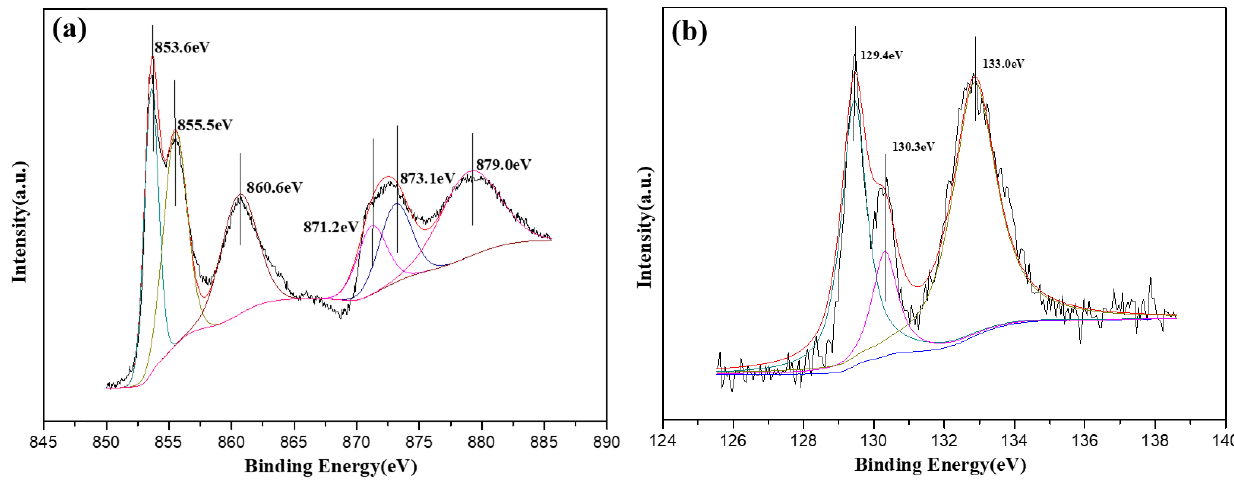
Figure 6. Peak-splitting processing for the alloy coating with heat treatments. ( a ) Peak splitting of Ni at 400 °C, ( b ) peak splitting of P at 200 °C. Table 2. Calibration results of Ni and P peaks during crystallization.